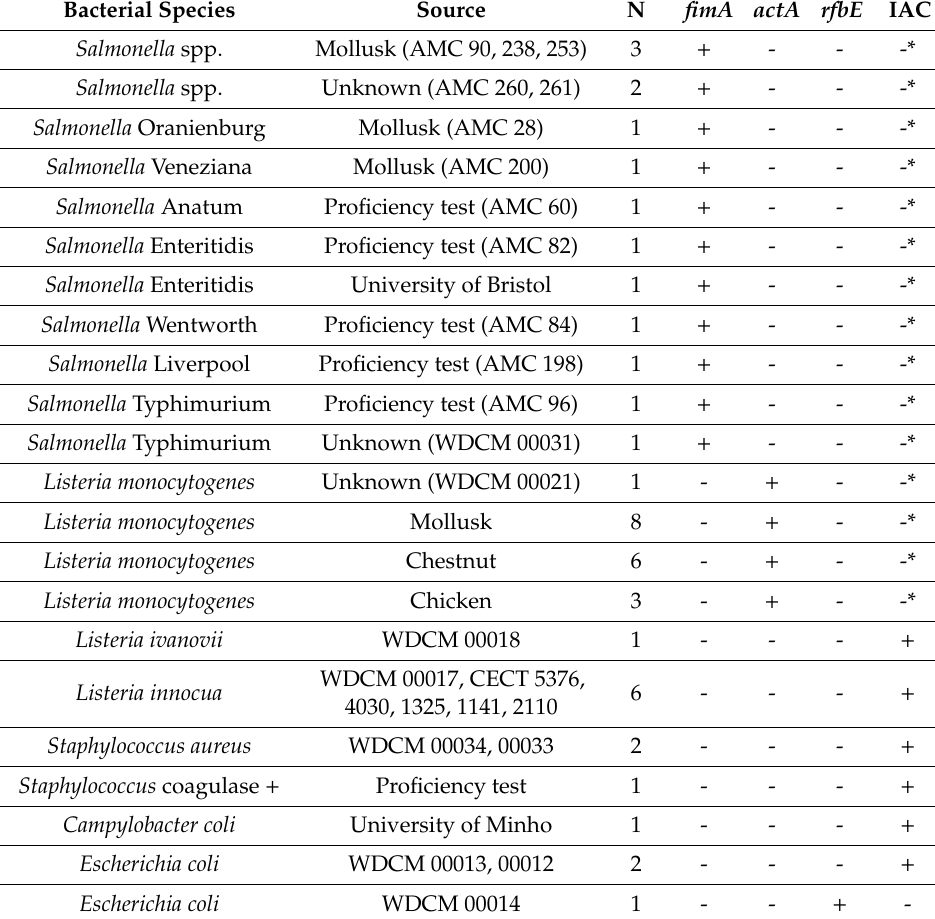
Table 1. List of bacteria strain used to evaluate the specificity of the primers and qPCR reaction. Bacterial Species Source N